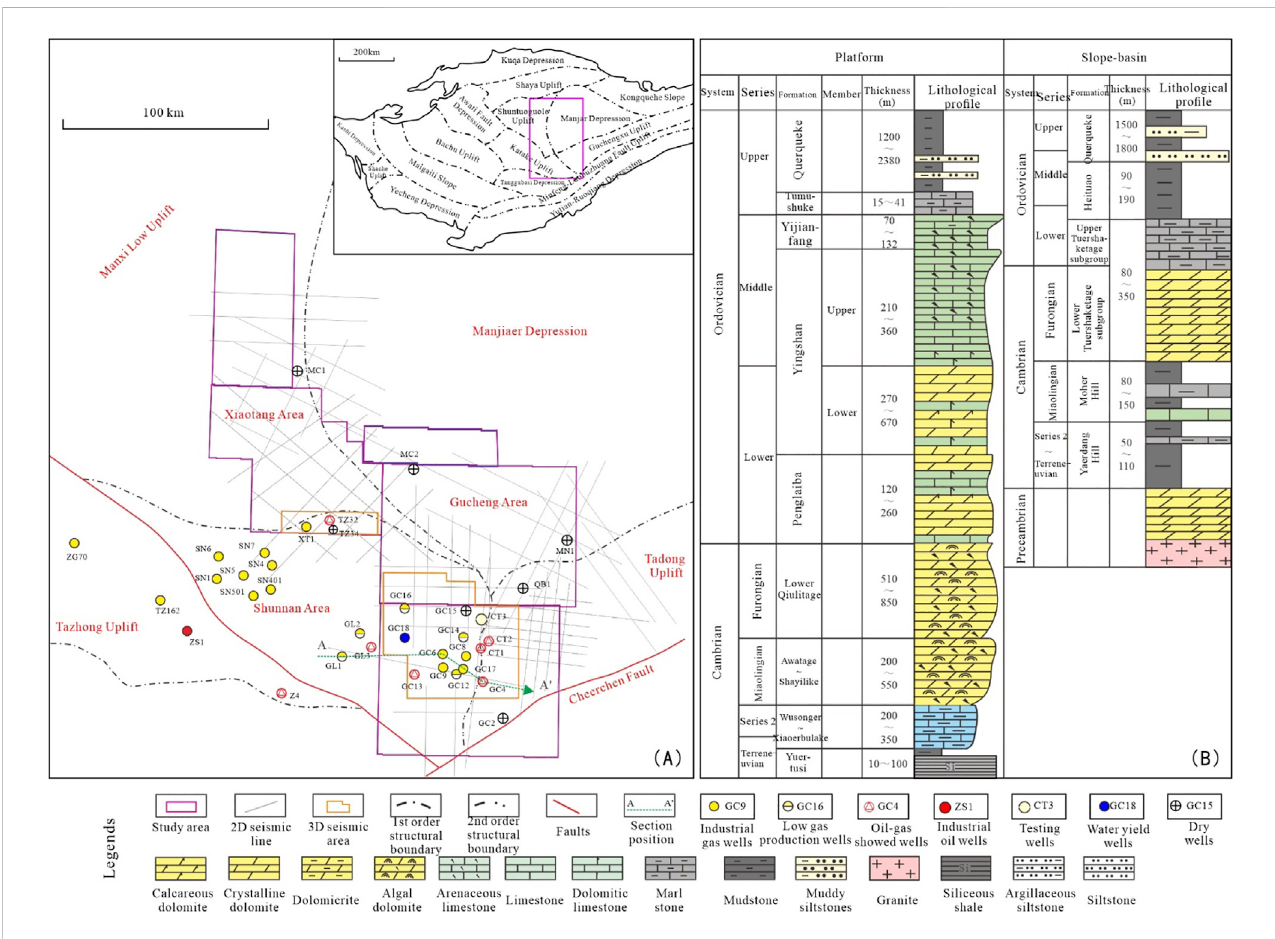
FIGURE 1 Geological setting of the Gucheng area. (A) . Structural location of the Gucheng area in Tarim Basin; (B) . Comprehensive stratigraphic column of the Ordovician.